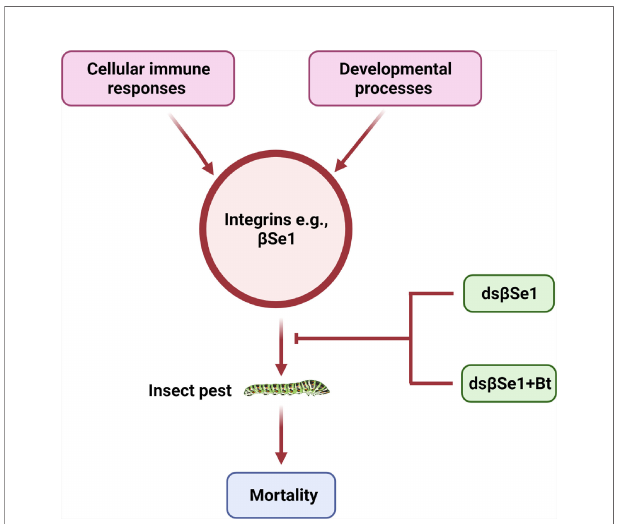
FIGURE 4 | Integrins as a target for insect pest control, e.g., integrin b Se1 is vital for the development, cellular immune responses, and the survival of insects. A novel class of insecticidal compounds can be generated by using one more of the potential